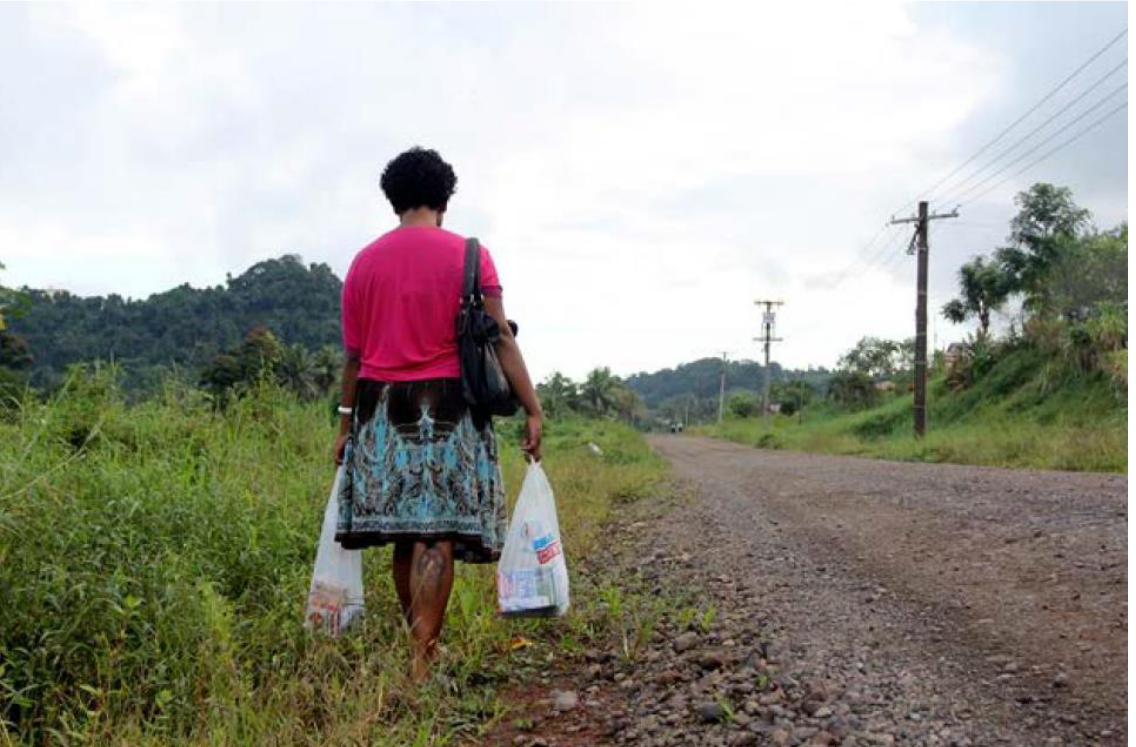
SCENARIO 6: Female socialising outside the home; women’s capacity to move independently in the community; women and girls’ capacity to safely move independently in remote